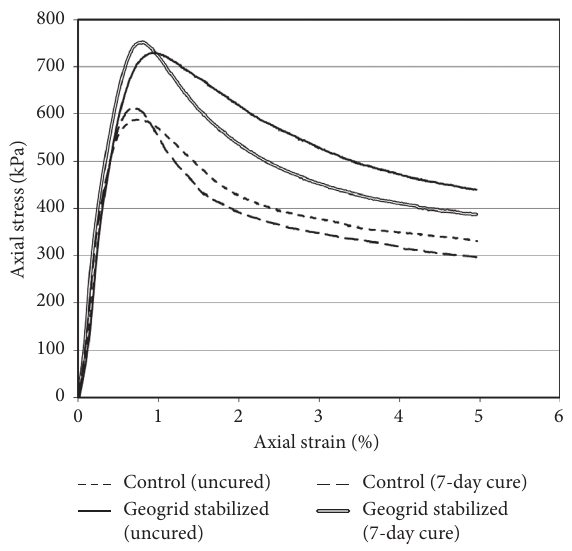
Figure 4: Quick shear results from the AASHTO T307